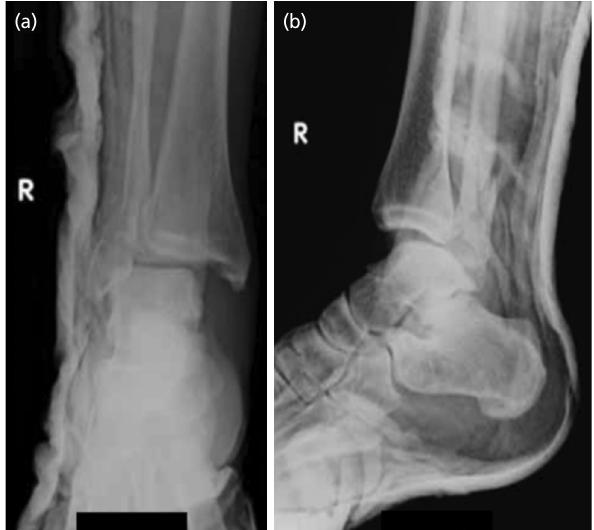
Fig. 1: Patient 1 – (a) Antero-posterior and (b) lateral radiographs on arrival showing a short oblique lateral malleolar fracture and postero-lateral subluxation of the talus with entrapment of the proximal fibula behind the